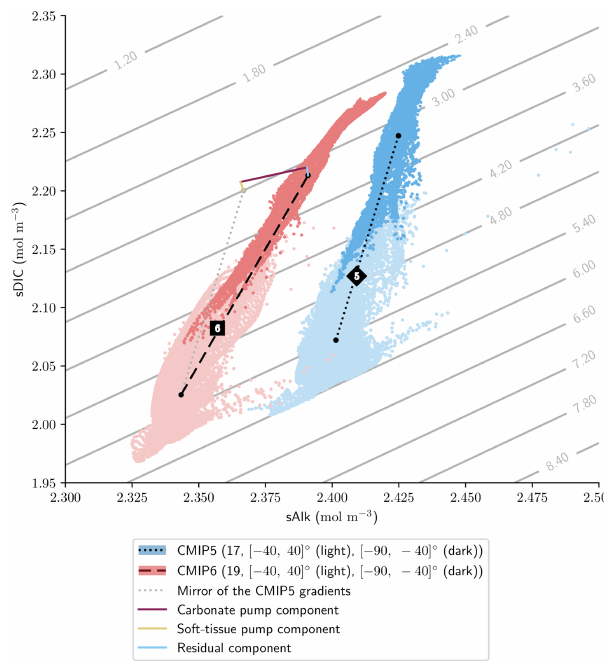
Figure 13. Scatter plot of the surface open-ocean sDIC and sAlk at low latitudes (light) and in the Southern Ocean (dark) for the CMIP5 (blue) and CMIP6 (red) ensemble means. The meridional gradient between low latitudes and the Southern Ocean mean val- ues is shown for CMIP5 (dotted) and CMIP6 (dashed) alongside the global open-ocean mean value for CMIP5 (diamond) and CMIP6 (square). The additional lines plotted for CMIP6 give the contri- bution of the biological pumps and a residual component to the increase in the meridional gradient from CMIP5 to CMIP6. This highlights that the carbonate pump (purple) is the main driver of the enhanced meridional gradients of Alk and DIC. Grey background lines give the calcite saturation state calculated with mean open- ocean surface temperature, salinity, silicate and